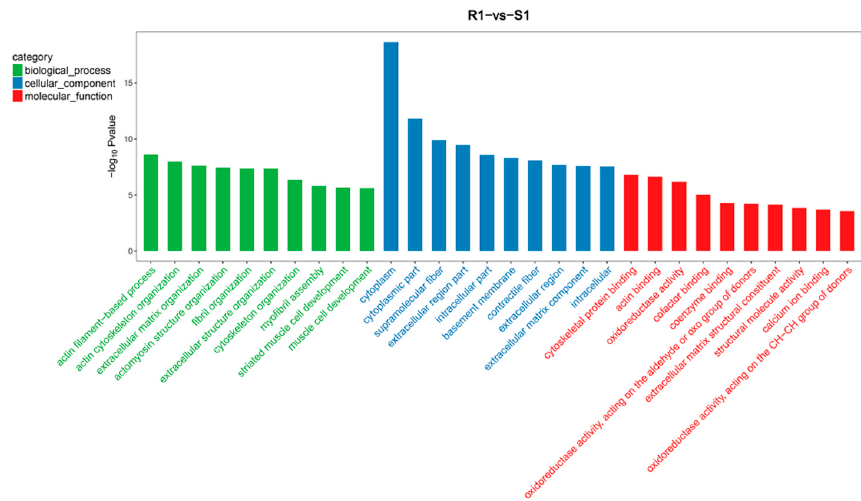
Figure 6. The 30 most significantly enriched gene ontology (GO) terms for the DEPs in the four comparison groups. The GO analysis results are summarized in three categories: biological processes (green), cellular components (blue), and molecular functions (red). The X -axis indicates different GO terms, and the Y -axis represents the corresponding number of genes in each GO term.